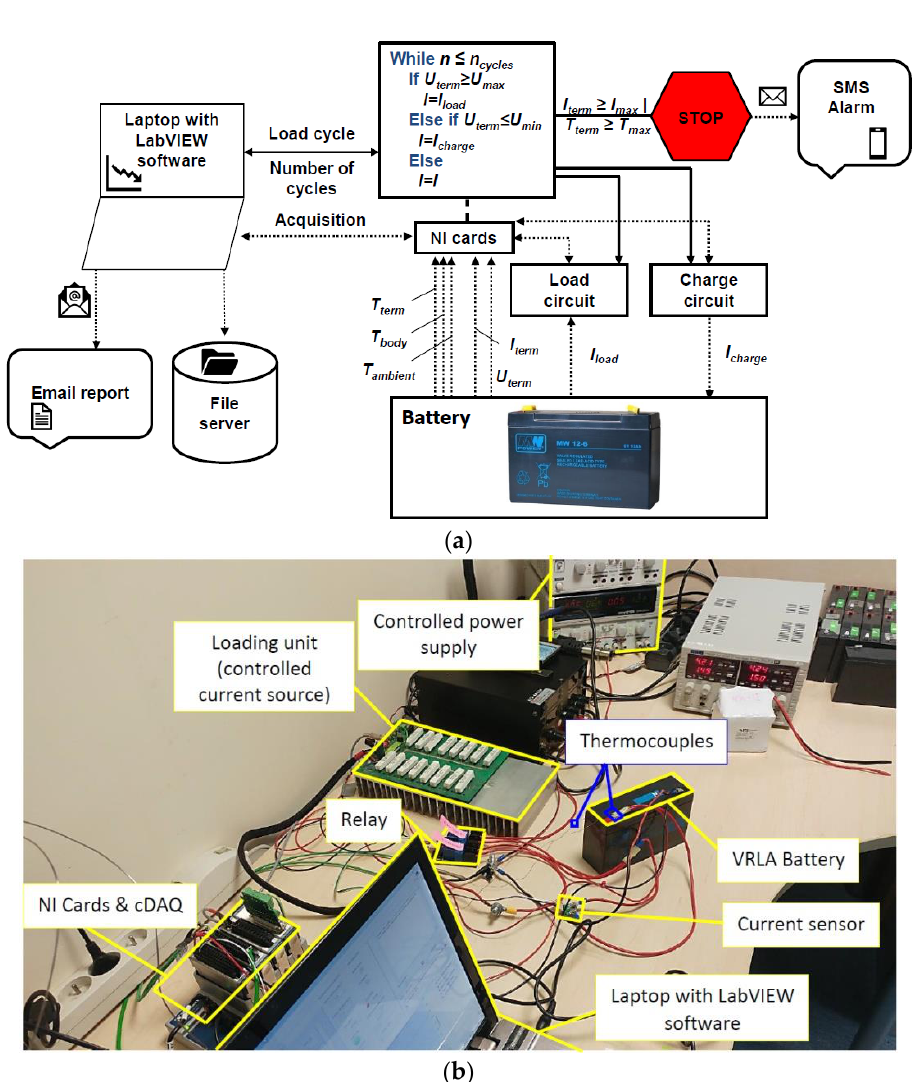
Figure 1. The test stand: ( a ) General scheme; ( b ) photograph [29].